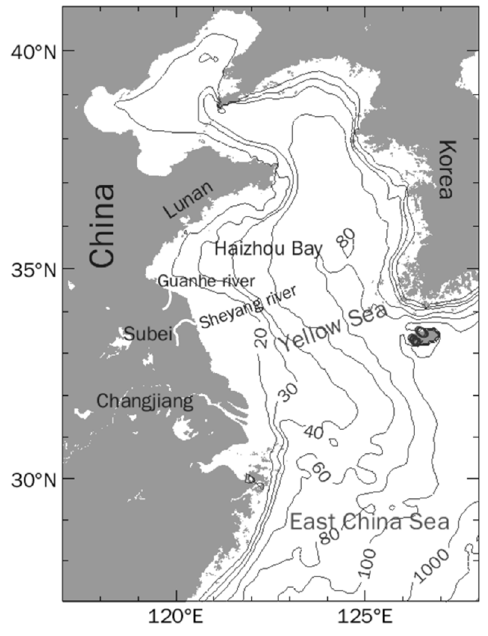
Figure 1. Model domain with geography and bathymetry (unit: m).